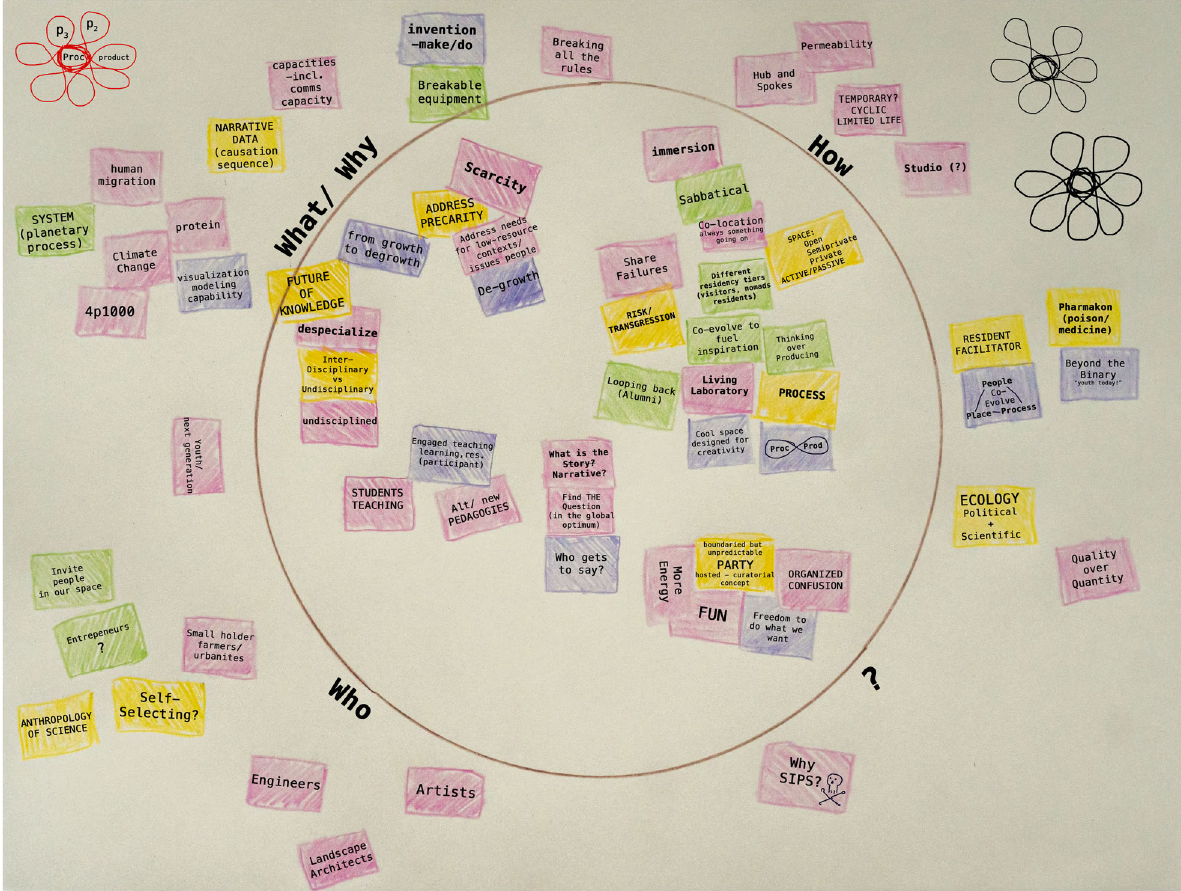
Fig. 1 Identi fi cation of motivation for engaging in an interdisciplinary activity. Motivations used to identify categories of WHAT/WHY, HOW, and WHO (De fi nitions in Box 1). Outcome of a workshop lasting 6 h on January 15, 2020 with three plant-science faculty, one communications specialist, one expert in organizational development, and an artist/arts-based researcher. Note the ‘ fl ower ’ forms which represent an attempted visualization of an interdisciplinary process — movement around a core principle with various ‘ petals ’ /projects that then cycle back and feed the center